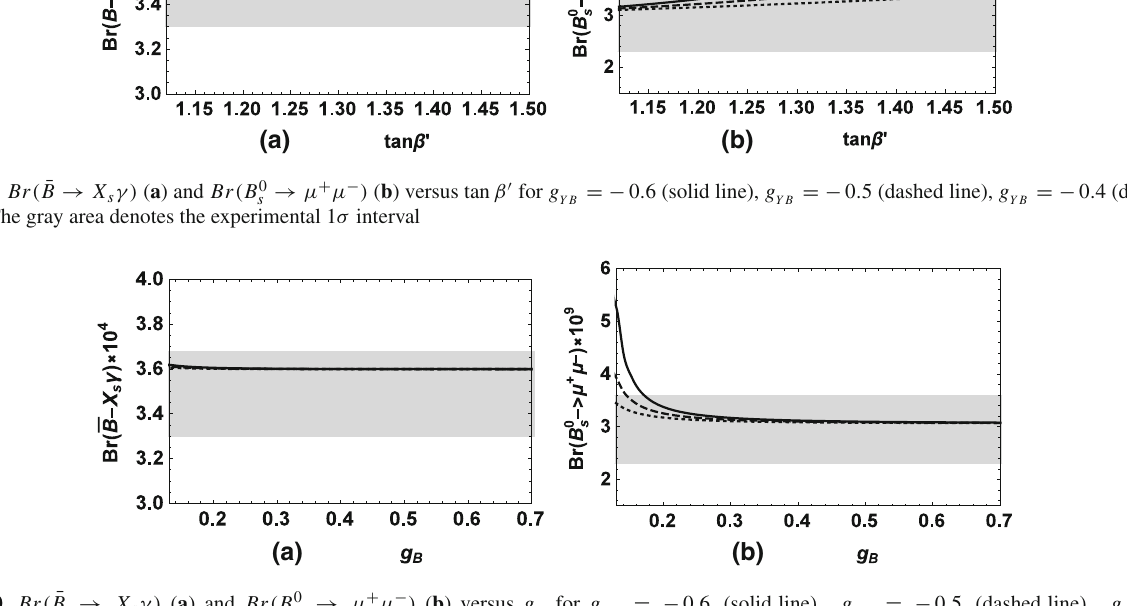
Fig. 10 Br ( ¯ B → X s γ) ( a ) and Br ( B 0 s → μ + μ − ) ( b ) versus g − 0 . 4 ( dotted line ) . The gray area denotes the experimental 1 σ interval